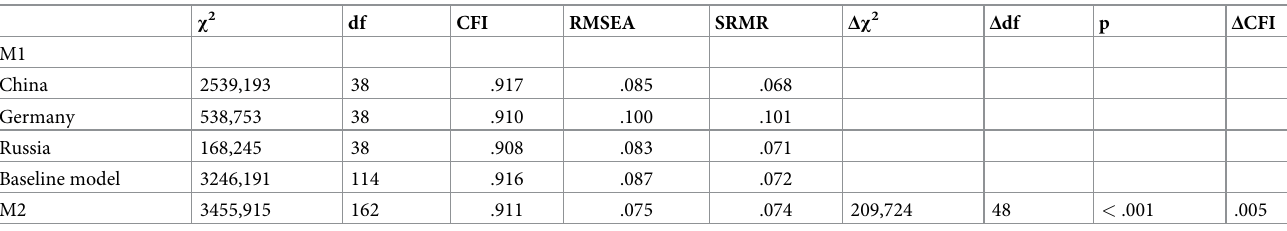
Table 3. Fit indices for the unconstrained and constrained